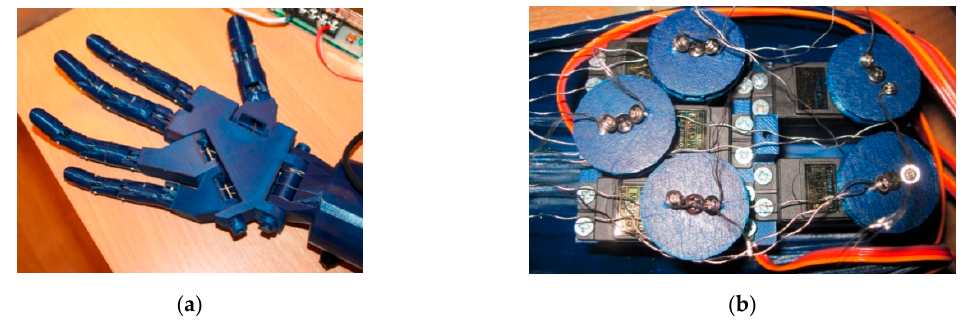
Figure 10. Anthropomorphic gripper with five fingers: ( a ) Constructive version; ( b ) The stepper motors.